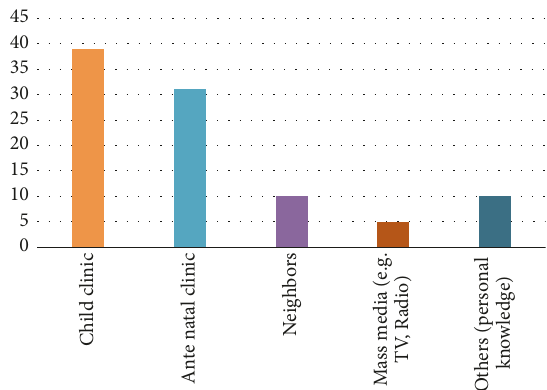
Figure 3: Source of information on danger signs of infancy. Most of the caregivers reported their main source of information on the danger signs of infancy was child